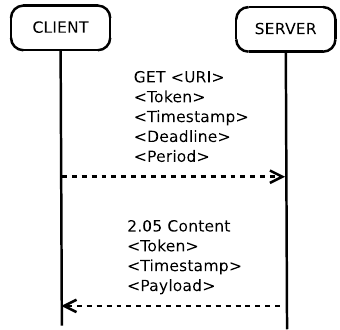
Figure 3. Send_Data_Req() and Send_Data() primitives as CoAP Request/Response